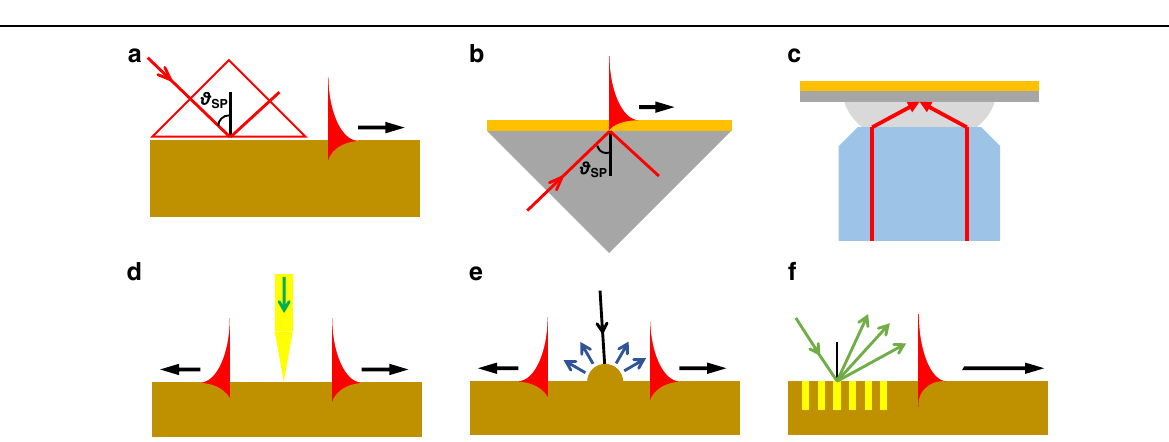
large incident angle to cover the excitation angle that satis fi es the matching condition enables plasmons to be excited on the upper surface of a metal fi lm 39 , as shown in Fig. 2c. The plasmons propagate towards the centre and then interfere to produce a strong convergence point (also known as a virtual probe), which can be combined with traditional microscopic systems. This principle is widely used in biological imaging, sensing and other fi elds 40 – 43 .